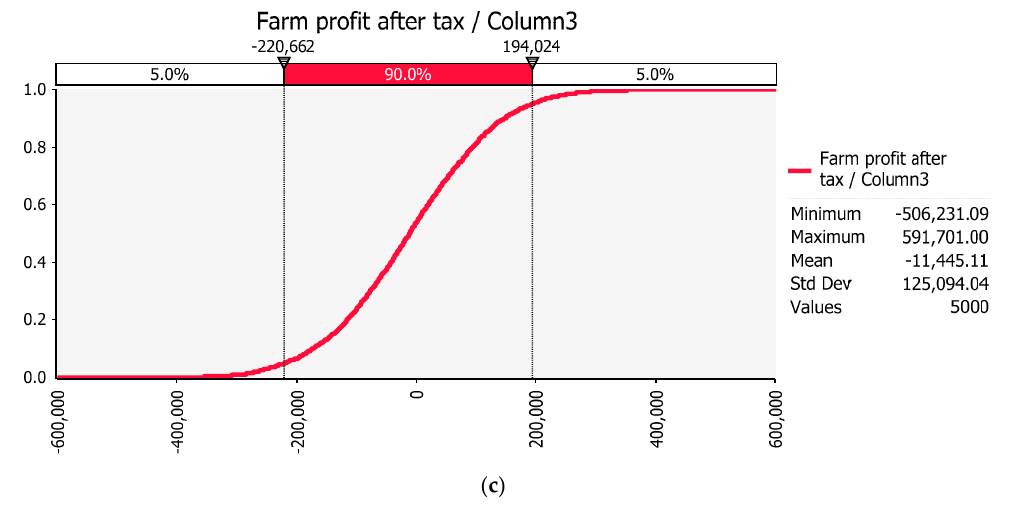
Figure 4. “@Risk” simulated risk profile for the sheep and beef farm, showing distribution of after tax profit ( a ); tornado chart ( b ); cumulative distribution of profits ( c ).